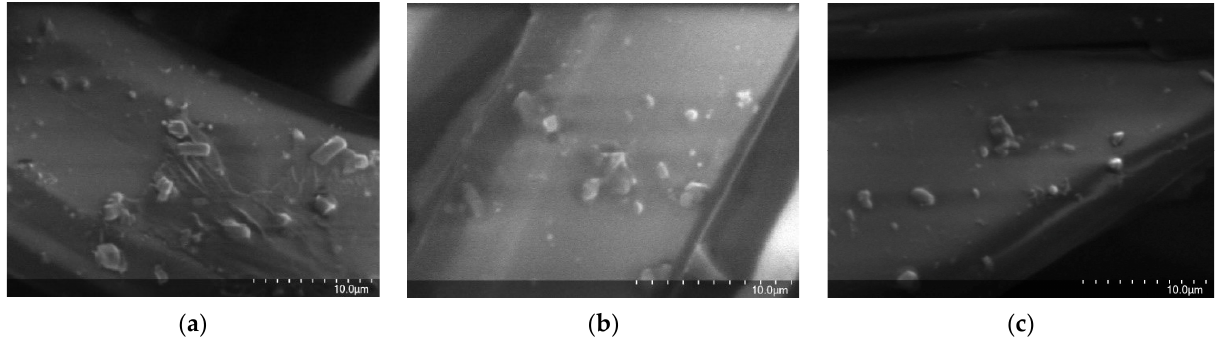
Figure 4. SEM images of OEO-NCs on PES textiles: ( a ) OEO-NC-treated PES, ( b ) OEO-NC + citric acid-treated PES ( c ) OEO-NC + resin-treated PES. acid-treated PES ( c ) OEO-NC + resin-treated